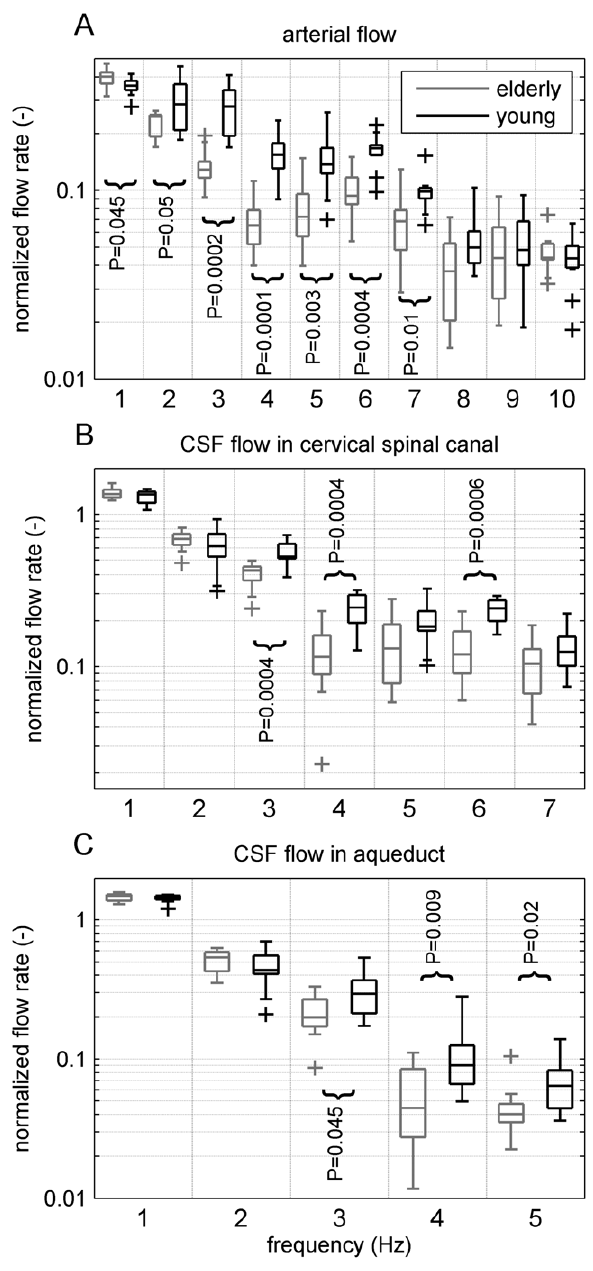
Figure 2. Juxtaposed frequency components (Hz) of flow in the elderly (gray, left) and young groups (black, right) illustrated using Boxplots. The upper and lower edges of each box represent the 25th and 75th percentiles, respectively. The center line represents the median and the whiskers extend to the most extreme data points not considered outliers, which are plotted individually ( + ). In each subfigure, frequency components are separated by dotted lines. In A , the first to the 10th frequency components of the combined flow rates in the carotid and the vertebral arteries are plotted, in B , the first to the seventh frequency components of the cerebrospinal fluid (CSF) flow rate in the cervical spinal canal at the level of C3–C4 and in C , the first to the 5th frequency components of CSF flow rate in the aqueduct. Curly brackets indicate significant differences of the respective frequency component’s magnitudes detected with the Mann-Whitney test. Note that the fourth frequency components of the arterial flows A hardly overlap, thus the corresponding asymptotic 2-tailed p-value is 0.0001.